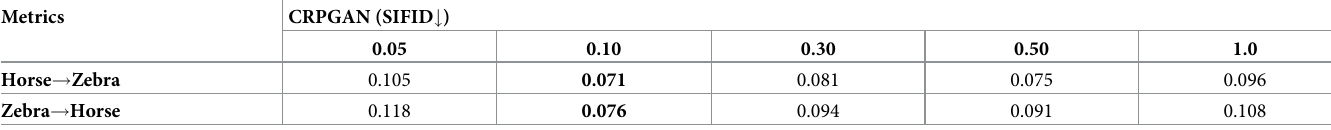
Table 3. Quantitative comparison between different scale factor η of CRPGAN in terms of SIFID. The best scores are in bold.